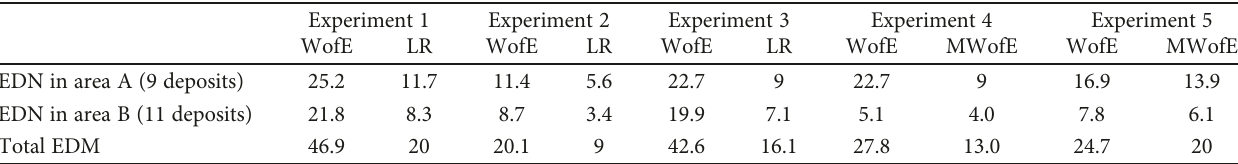
Table 5: Estimated deposit number (EDN) for three methods in the 5 experiments; modi fi ed weight-of-evidence (MWofE) for experiments 4 and 5 in the last two columns.